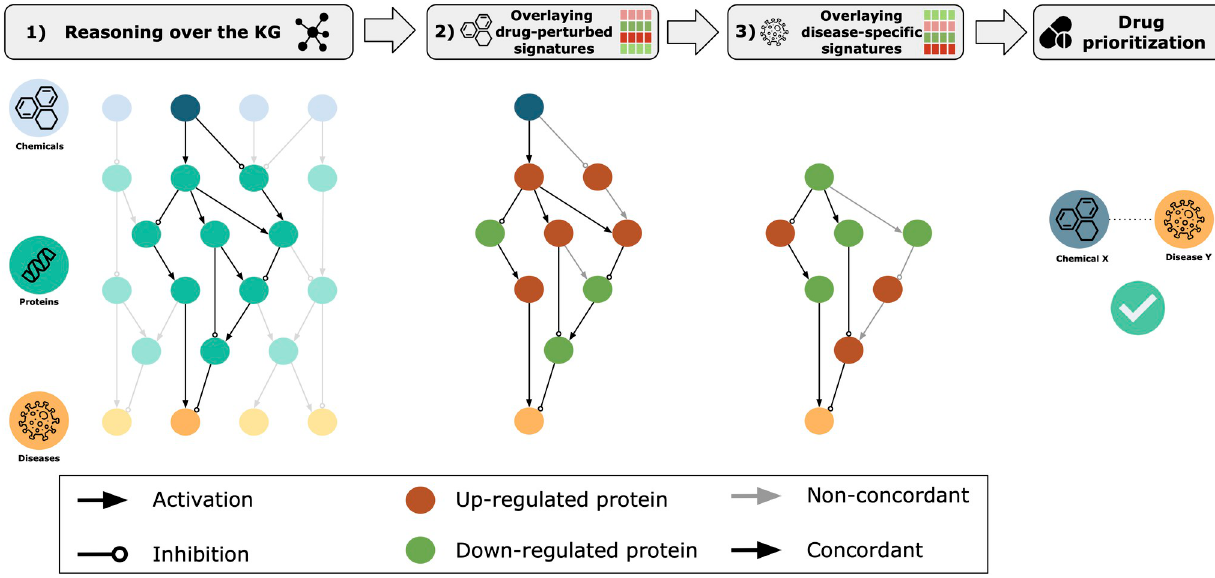
Fig 1. Schematic representation of the RPath algorithm. Step 1) All acyclic paths of a given length between a drug and a disease in the KG are calculated. If there exist causal acyclic paths connecting the drug and the disease, a subgraph involving all these paths is inferred. This subgraph represents the proposed mechanism of action by which the drug may be a therapeutic target of the given disease. Step 2) Transcriptomic signatures observed from a drug-perturbed experiment are overlaid onto each corresponding node present in these paths. Then, RPath traverses through each path and evaluates whether the inferred direction of regulation (i.e., activation or inhibition) at every step is concordant with the up- and down- regulations (i.e., red and green nodes, respectively) observed in the transcriptomic signatures. Step 3) In a similar manner, transcriptomic signatures observed within a specific disease context are overlaid onto each corresponding node in the concordant paths from the previous step (if any). Next, RPath evaluates whether the disease transcriptomic signatures contradict the paths that were concordant with the drug signatures. If this is the case, the specific drug-disease pair is prioritized.